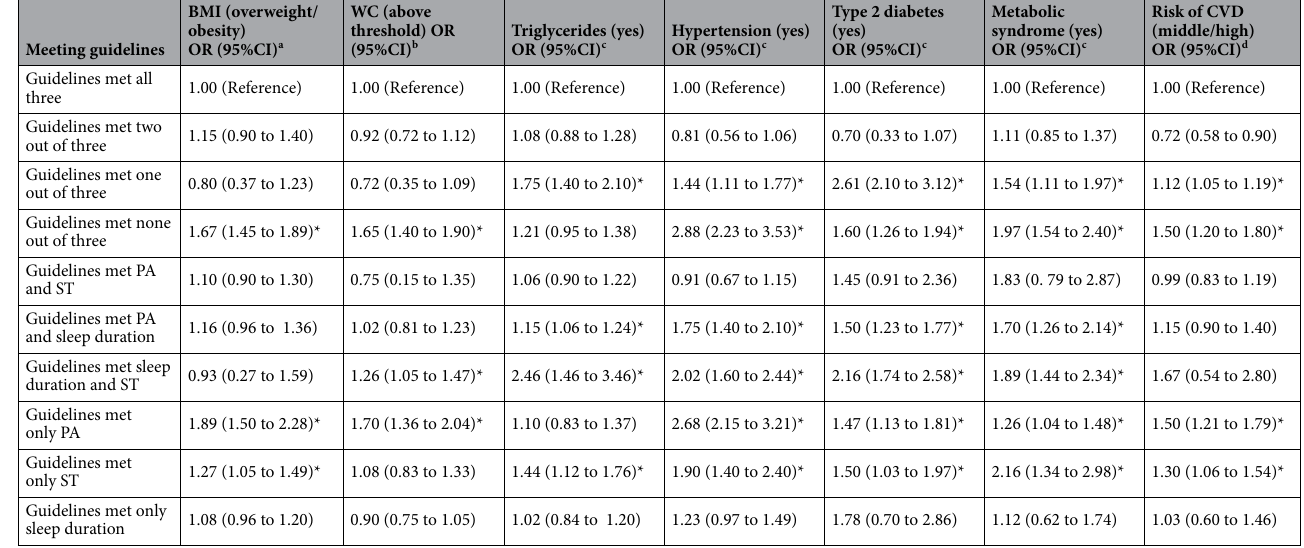
Table 3. Multivariable logistic regression models for the associations of meeting physical activity, sitting time, sleep duration, and combinations of these recommendations with cardiometabolic health in